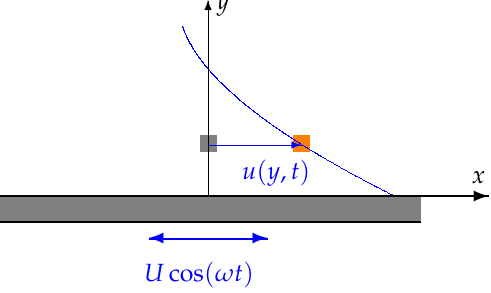
Figure 2. Schematic showing the geometry for the flow over an oscillating